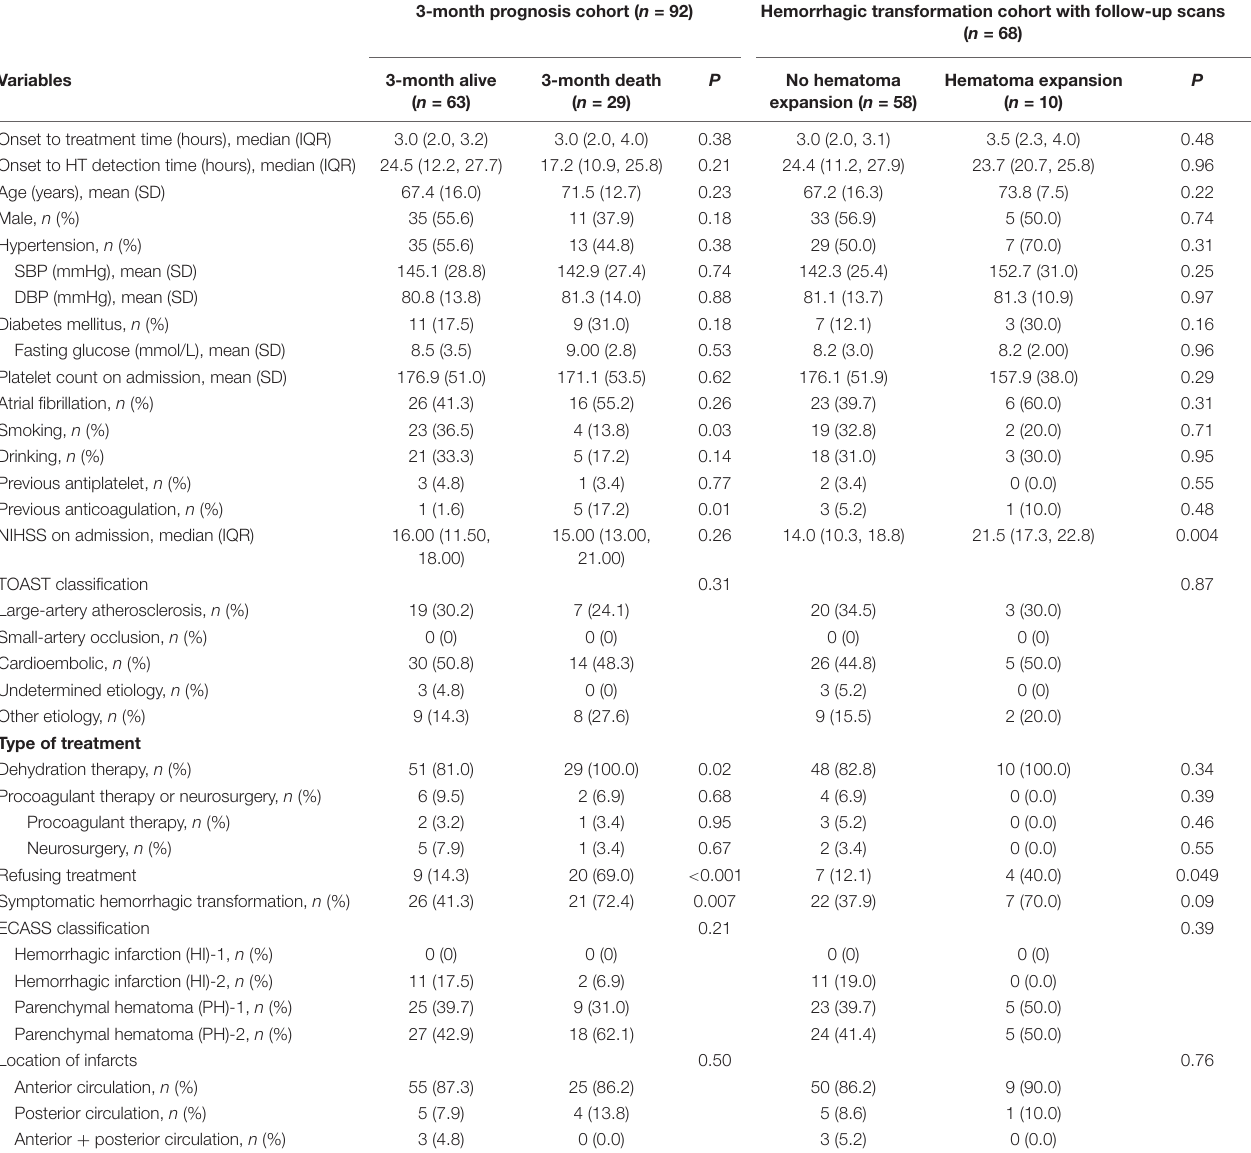
TABLE 2 | Univariate analysis of predictors of 3-month death and hematoma expansion. 3-month prognosis cohort ( n = 92) Hemorrhagic transformation cohort with follow-up scans